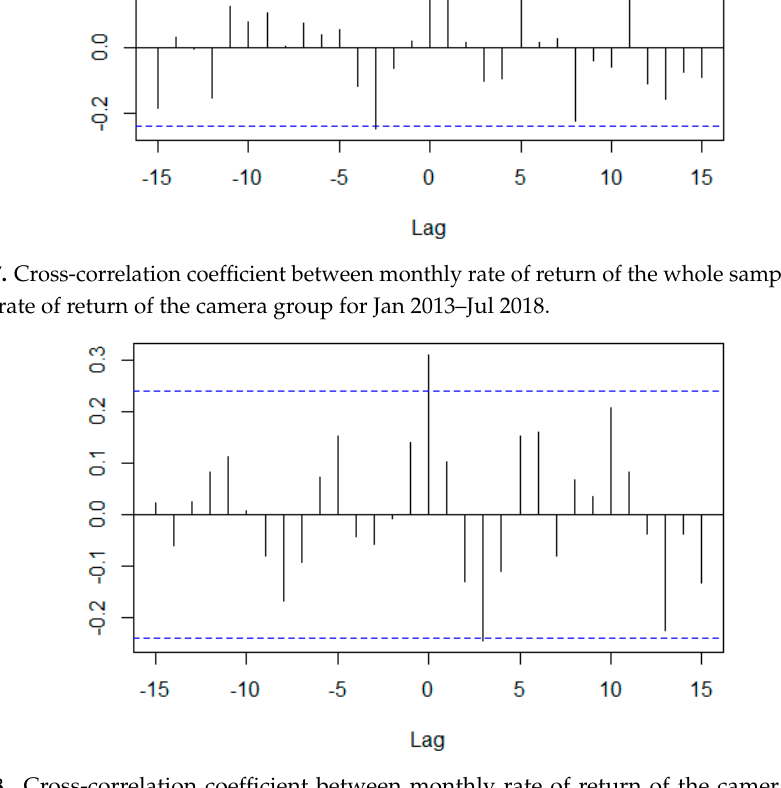
Figure 28. Cross-correlation coefficient between monthly rate of return of the camera group and monthly rate of return of the display group for Jan 2013–Jul 2018.